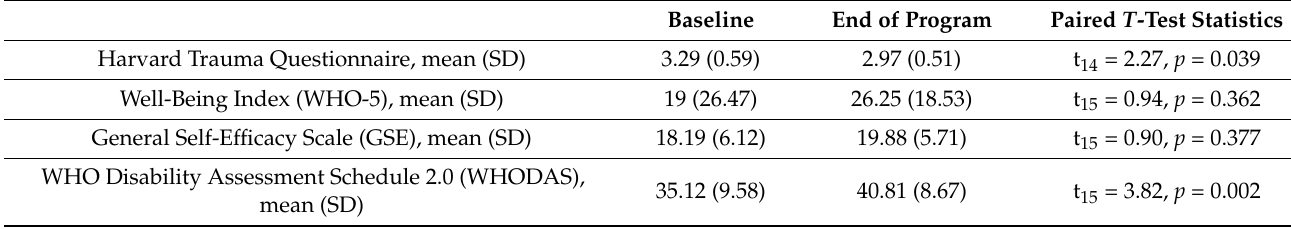
Table 4. Effect on mental distress and level of health, disability, and self-confidence. Baseline End of Program Paired T -Test Statistics Harvard Trauma Questionnaire, mean